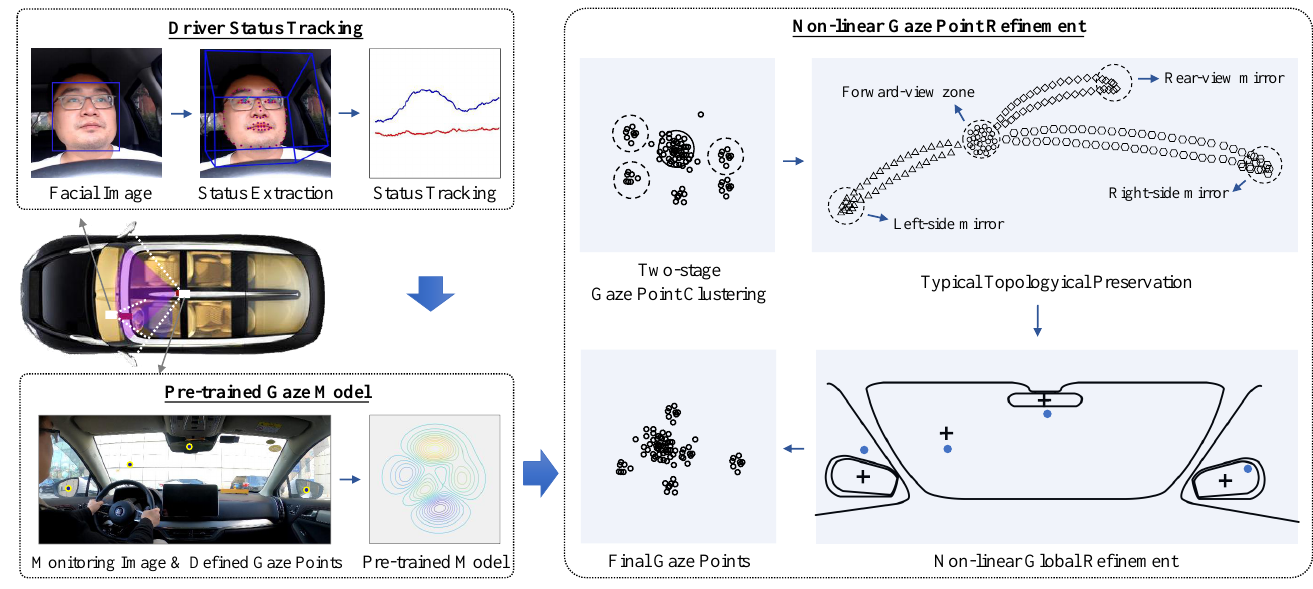
Figure 1. Overview of the proposed